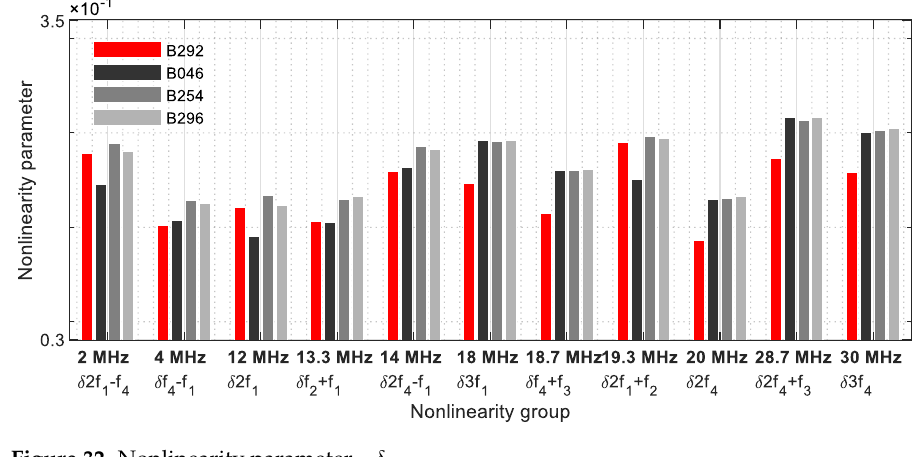
Figure 32. Nonlinearity parameter — δ G1 .